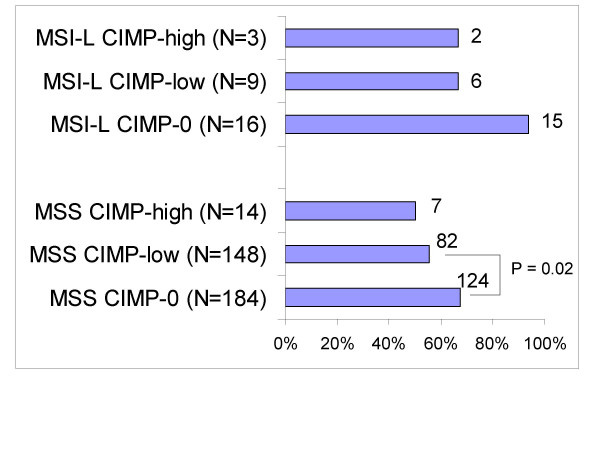
Frequency of 18q LOH in MSI/CIMP subtypes of colorectal cancer. CIMP-0 tumors show higher frequencies of 18q LOH than CIMP-low and CIMP-high tumors within the MSI-L and MSS subgroups. Abbreviations: CIMP, CpG island methylator phenotype; LOH, loss of heterozygosity; MSI-L, microsatellite instability-low; MSS, microsatellite stable.